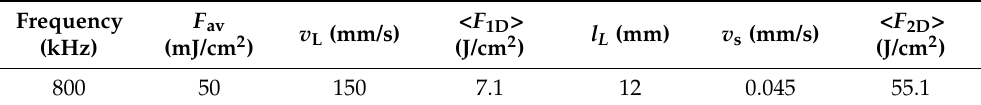
Figure 11. ( a , b ) Top-view SEM (SE) micrographs of the analyzed tape, before and after laser irradiation, respectively. Laser irradiation parameters are given in the text. ( c , d ) SEM (SE) micrographs showing a detail of the nano- and microstructures generated in the two selected areas highlighted in ( b ) with rectangles. The structure types (A1…A5) are indicated. Discontinuous (yellow) lines correspond to grain boundaries observed with EBSD maps, but not clearly visible in SEM images. Table 3. Laser parameters used in the processing of sample shown in Figure 11, used for the EBSD studies. The sample is moving in the direction perpendicular to the laser beam scanning one at a velocity given by v s .